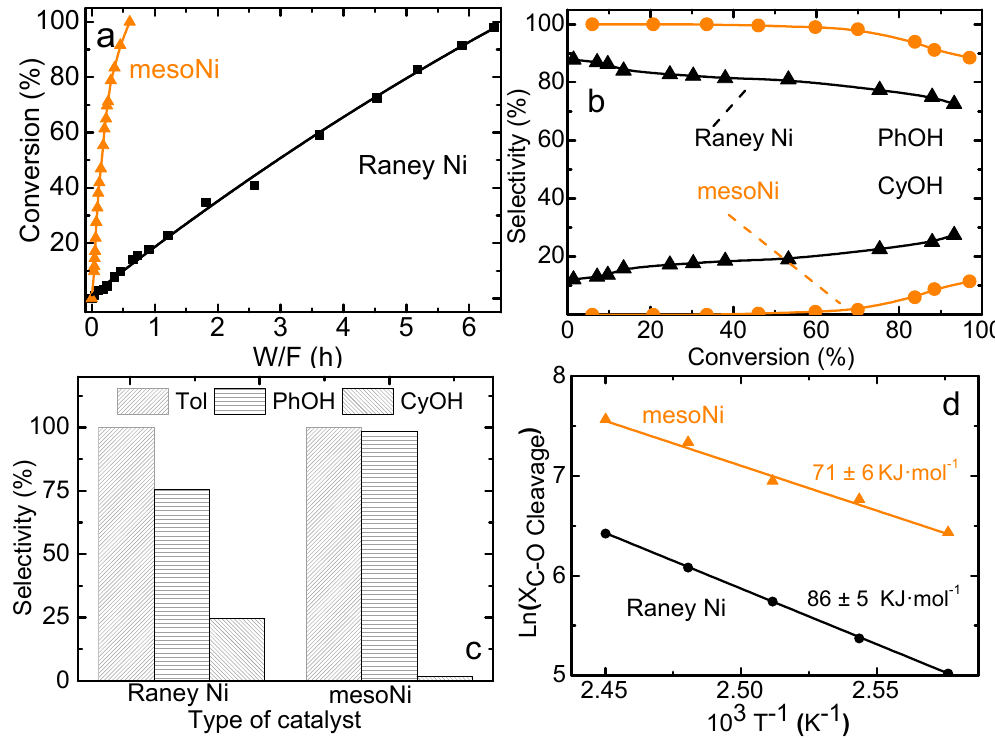
Figure 2. ( a ) Conversion as a function of space time (W / F) for hydrogenolysis of benzyl phenyl ether (BPE) and ( b ) major primary product distribution as a function of BPE conversion over mesoNi and Raney Ni catalysts. ( c ) Selectivity toward major products as W / F was adjusted to maintain a similar BPE conversion level (20% ± 2%). ( d ) Related Arrhenius plots and corresponding apparent activation energies (E a,app ) for hydrogenolysis of BPE. Reaction conditions: 120 °C, 20.0 mg catalyst, 2-propanol